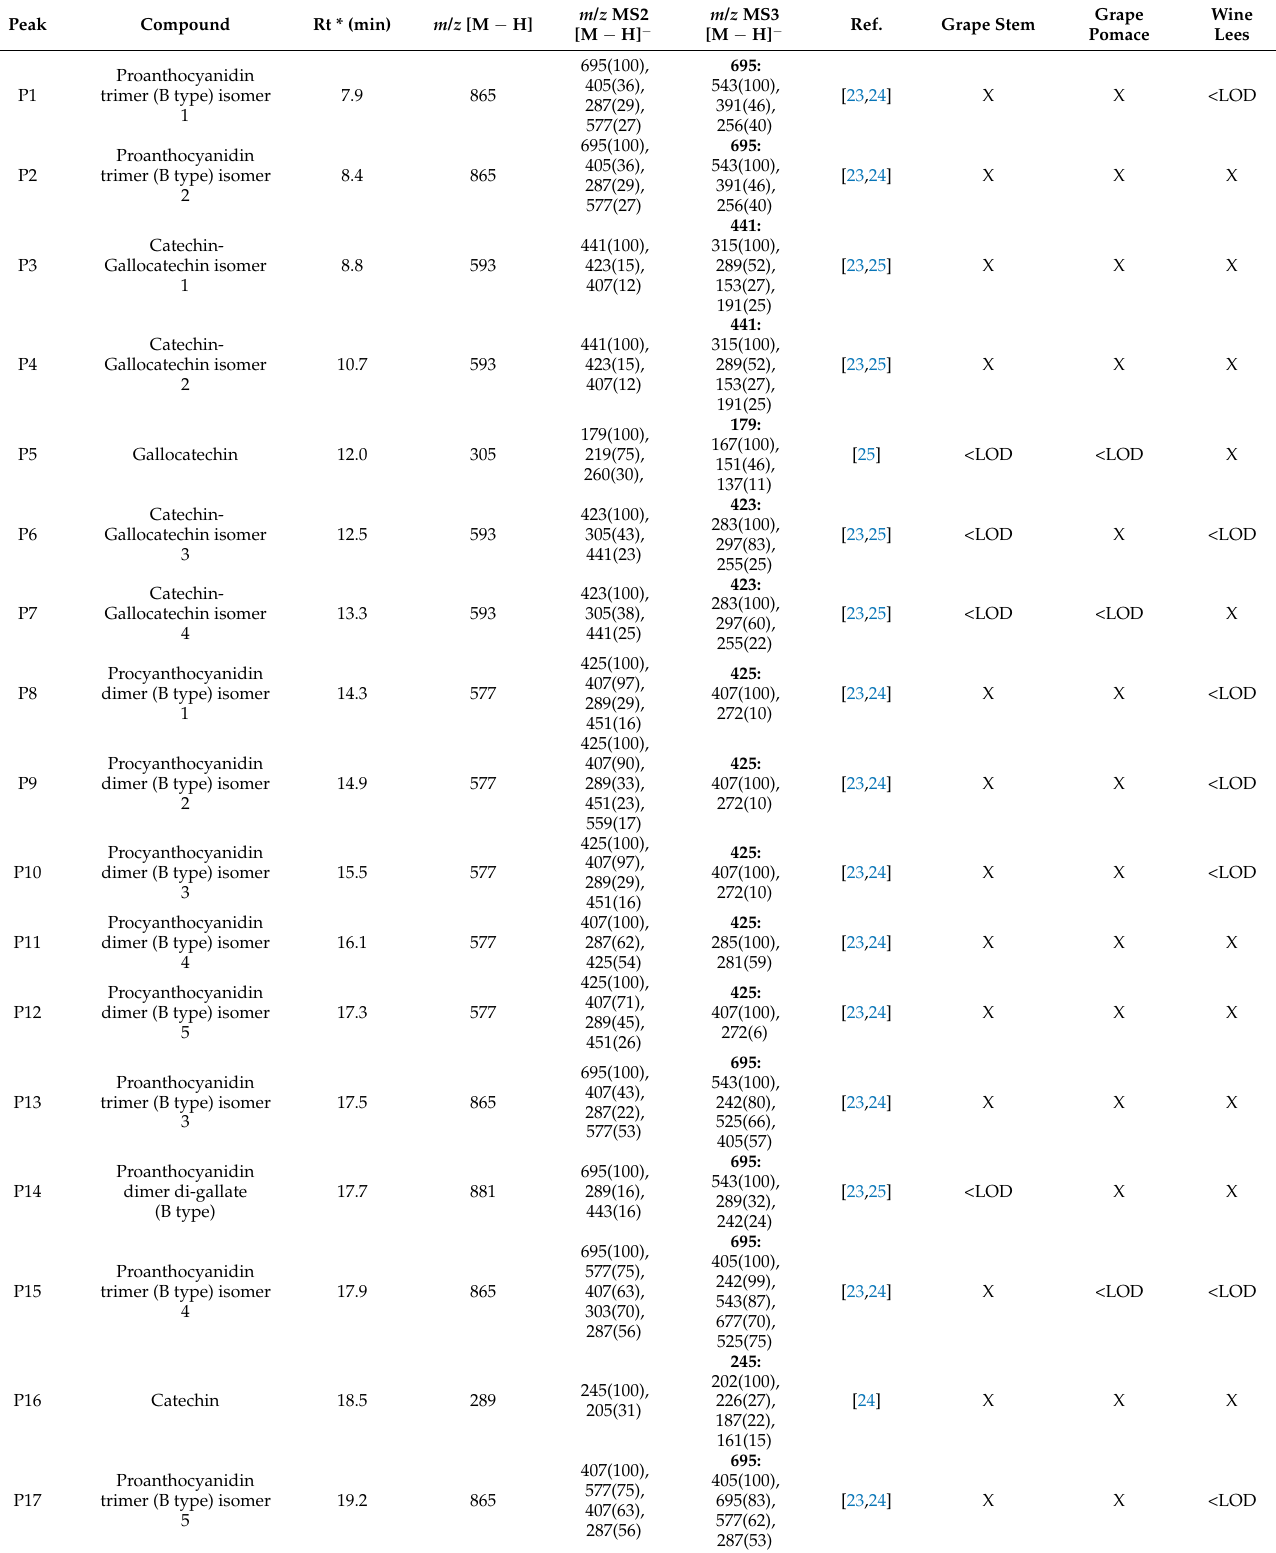
Table 1. Identified catechin derivatives and proanthocyanidins in grape ( Vitis vinifera L. var. ‘Monas- trell’) stem, pomace, and wine lees by HPLC-PDA-ESI-MSn operating in negative